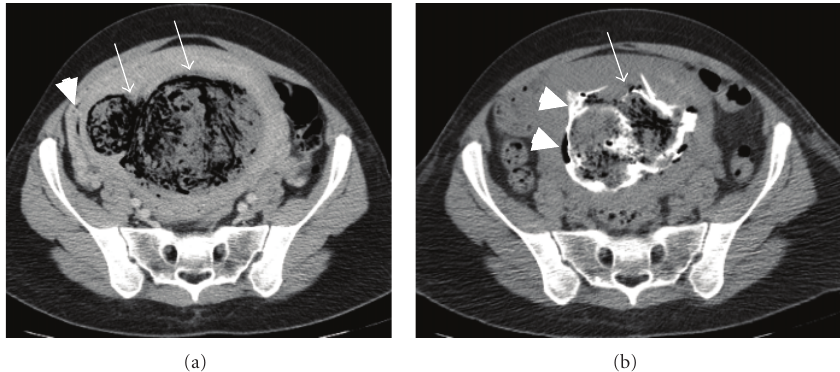
Figure 1: CT of the pelvis demonstrating (a) a large lobular gas containing intramural mass in the left uterine wall (white arrows). The uterine cavity is compressed to the right side (white arrowhead). (b) Following the injection of contrast material into the mass, the contrast is filling the mass (white arrow) and the uterine cavity (white arrowheads).